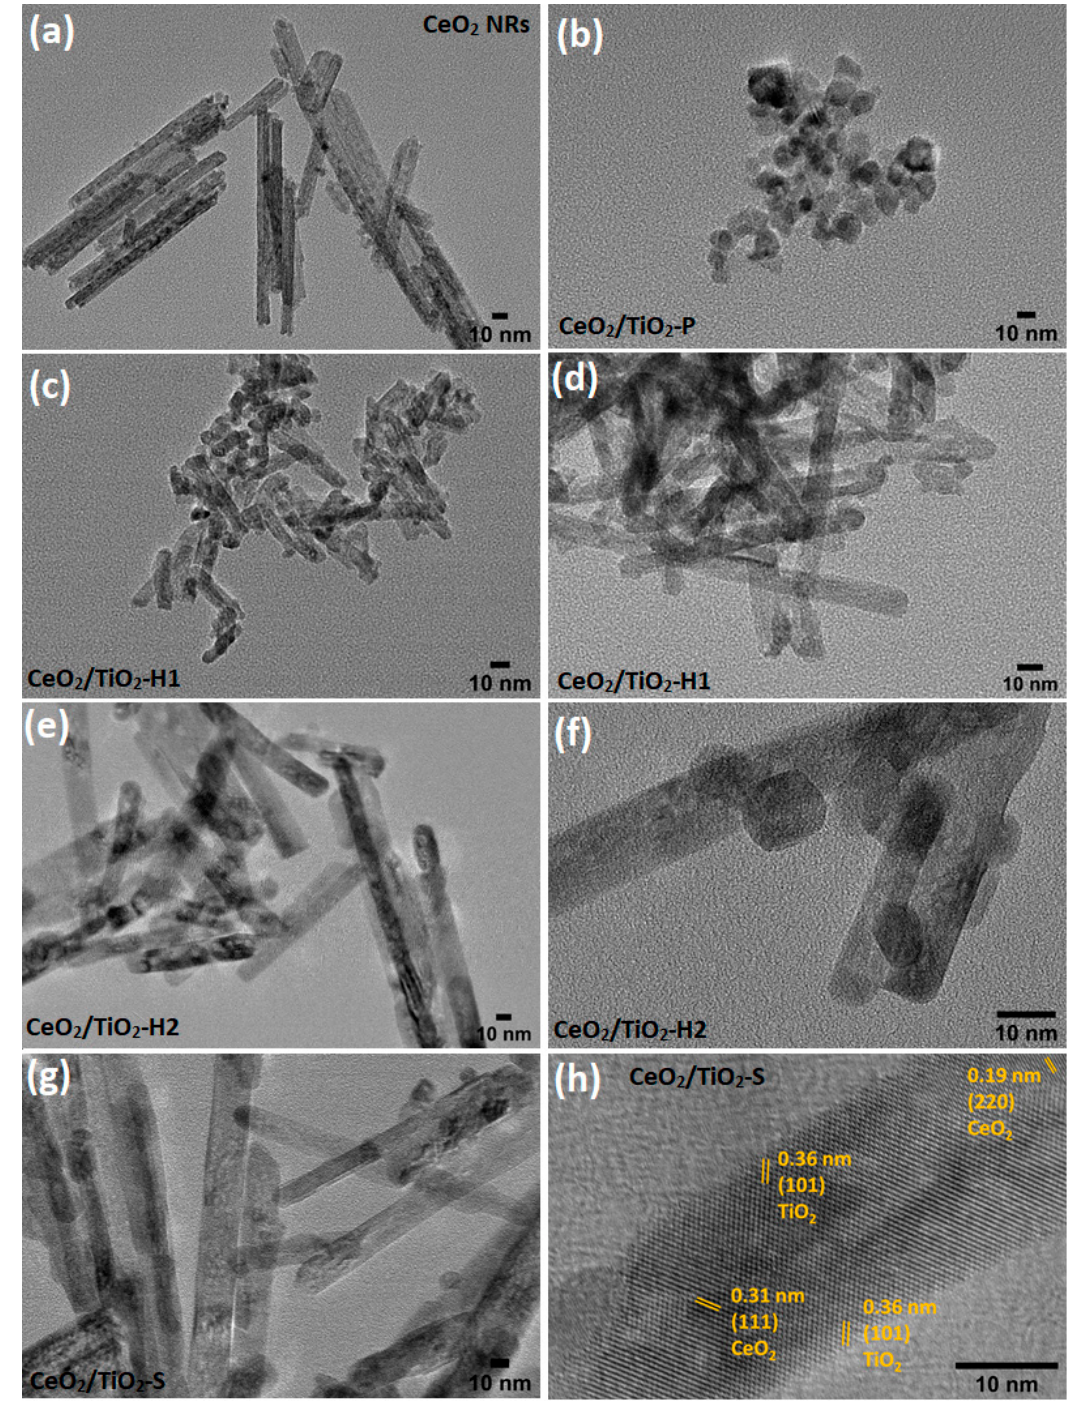
Figure 3. TEM images of the samples: ( a ) CeO 2 -NRs; ( b ) CeO 2 /TiO 2 -P; ( c , d ) CeO 2 /TiO 2 - Η 1; ( e , f ) CeO 2 /TiO 2 - Η 2; ( g ) CeO 2 /TiO 2 -S; ( h ) HRTEM images of CeO 2 /TiO 2 -S.